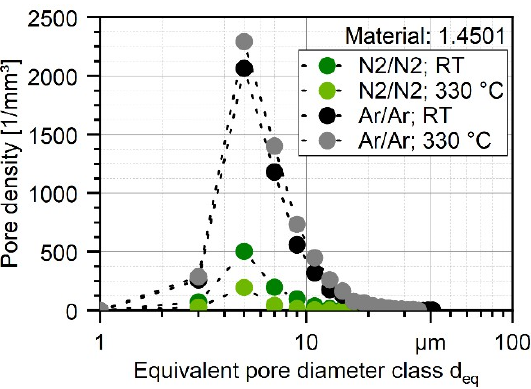
Figure 10. Pore density distribution of nitrogen and argon gas-atomized X2CrNiMoCuWN25-7-4 powders (particle size 20–63 µ m, voxel size 1.56 µ m) based on XRM measurements.